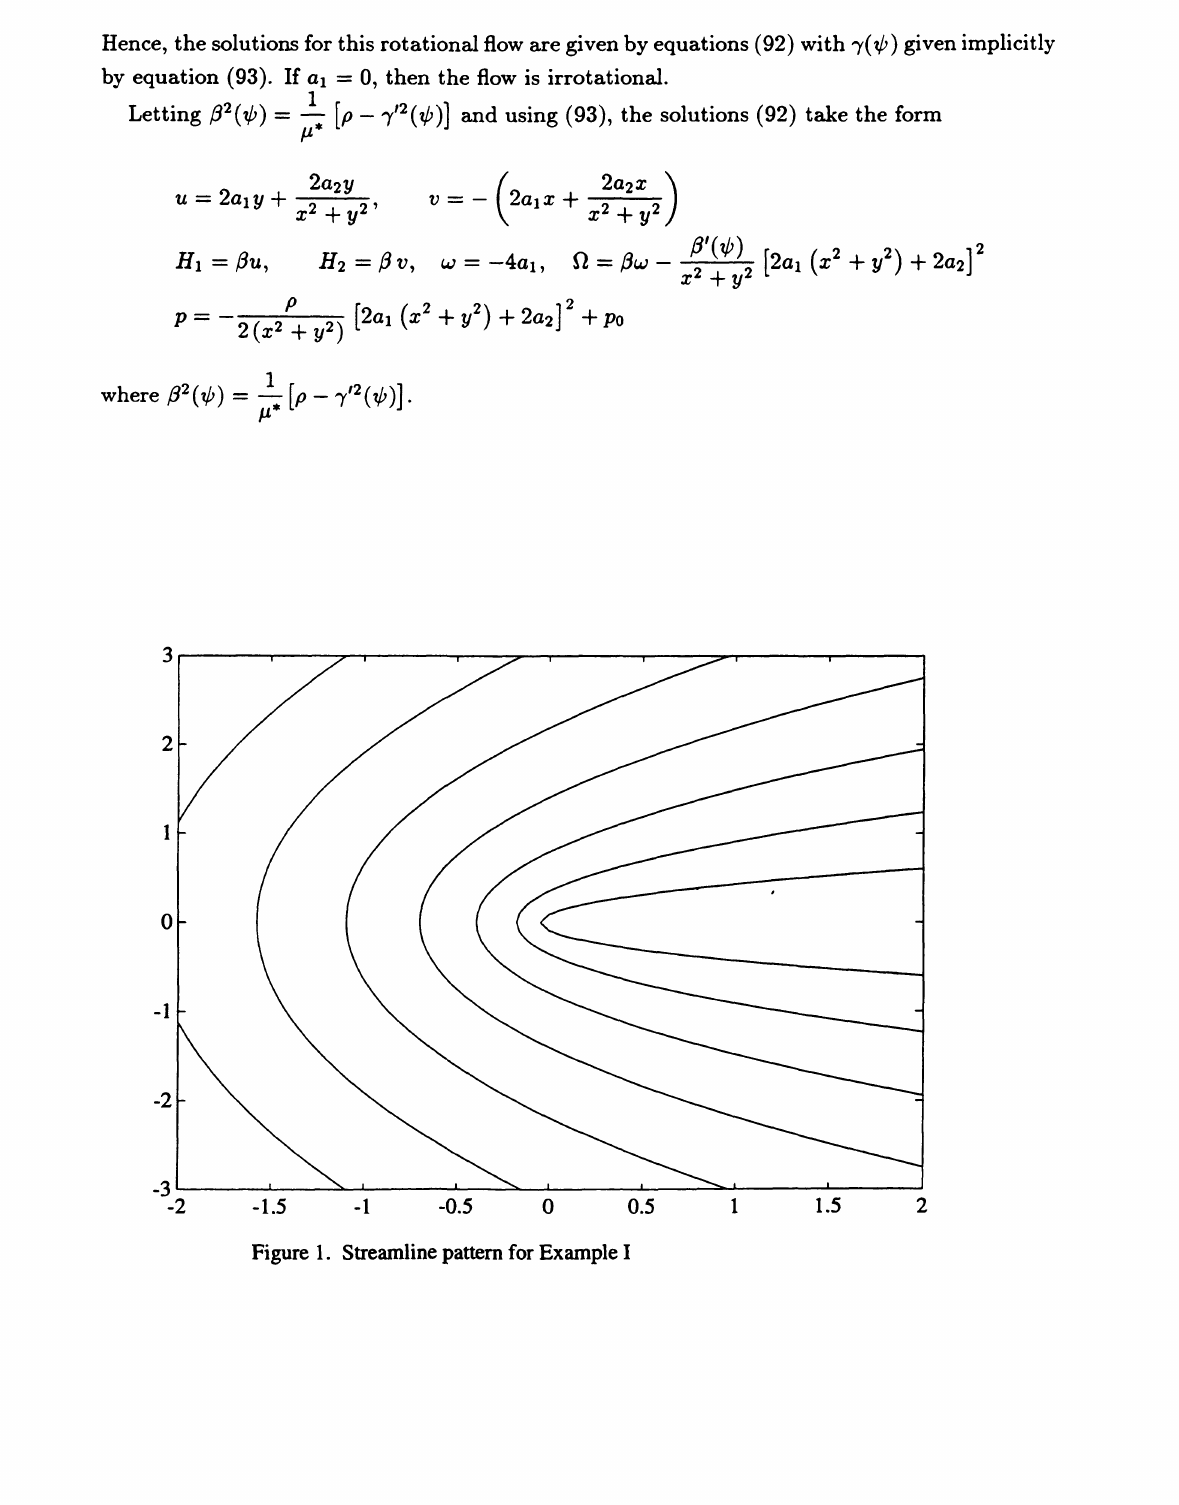
Figure 1. Streamline pattern for